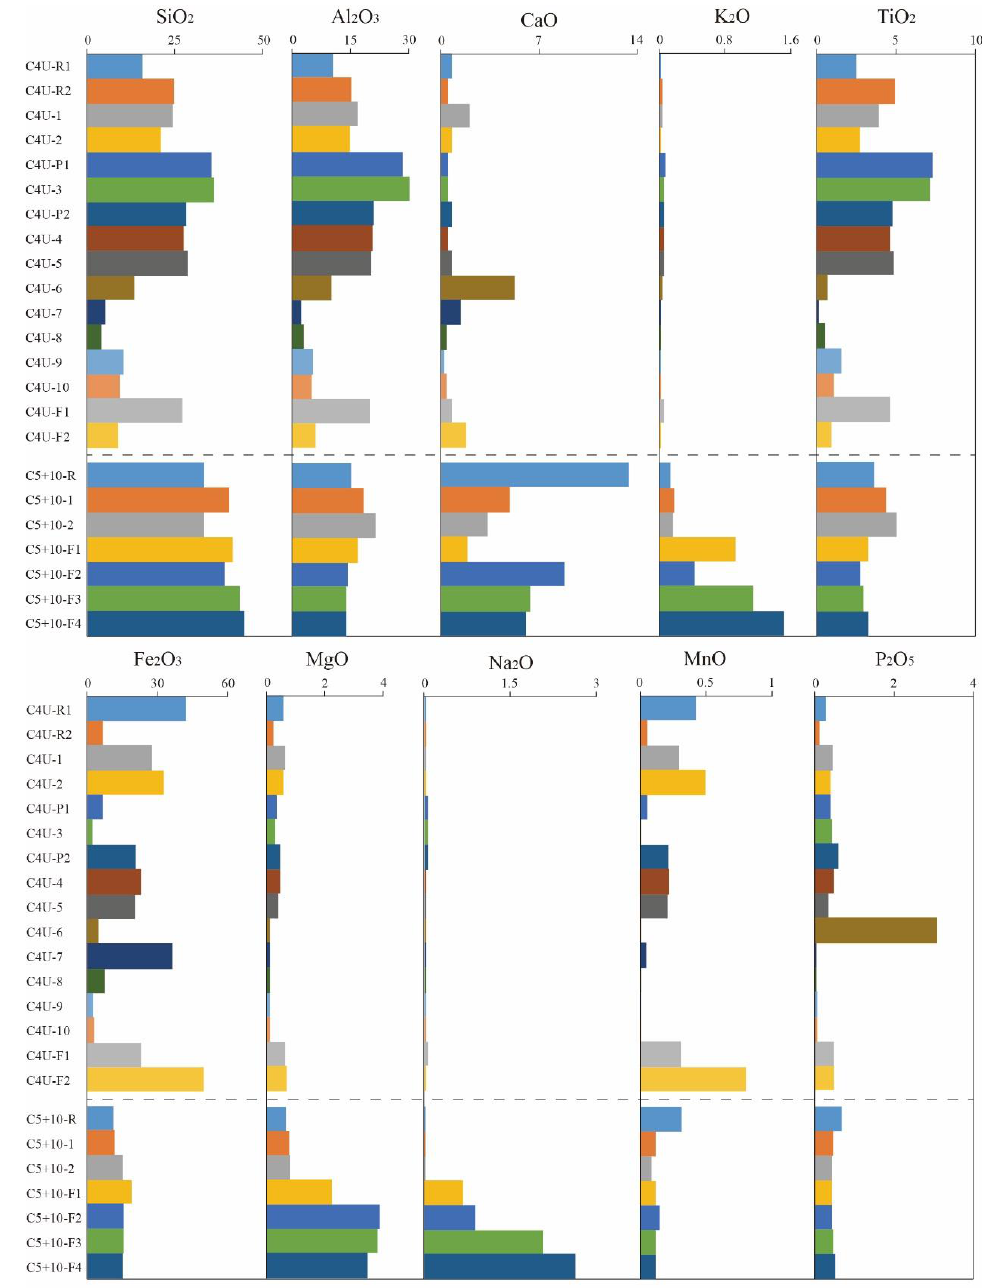
Figure 3. Vertical changes in contents of major oxides of the two coal seams. Note: Above the dashed line these samples are from the C4-Upper coal seam. Under the dashed line these samples are from the C5 + 10 coal samples. All contents are coal-basic, and the values of the abscissa are given in %.